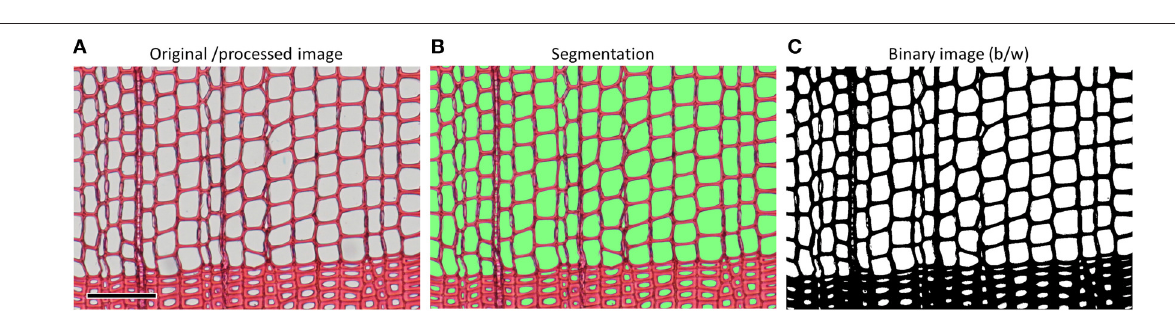
FIGURE 9 | Top row (A–C) shows how tracheid lumina obscured by a dust particle on the cover glass of a Pinus leucodermis sample remain undetected using ordinary image processing, bottom row (D–F) shows how contrast homogenization technique (using the image-analysis tool ROXAS in this case) allows to automatically detect all lumina. Scale bar = 100 µ m.